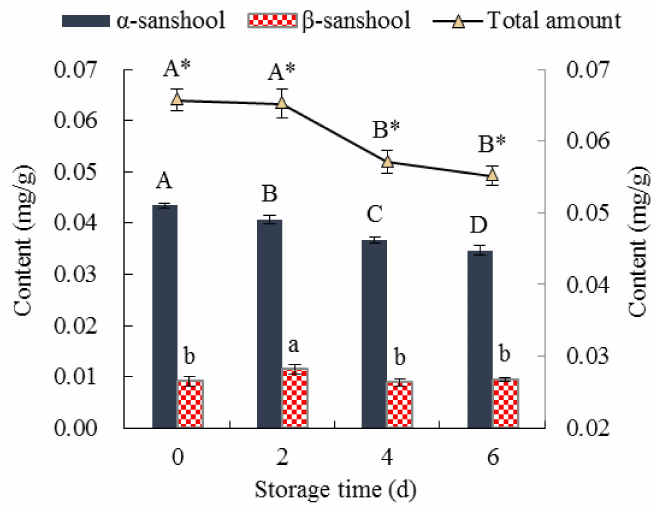
Figure 5. Numb taste of the marinated pork during cold storage. Values are presented as mean ± standard deviation. Different letters above the bars or points highlighting the standard deviation indicate significant differences ( p < 0.05). The asterisk indicates differences between capital